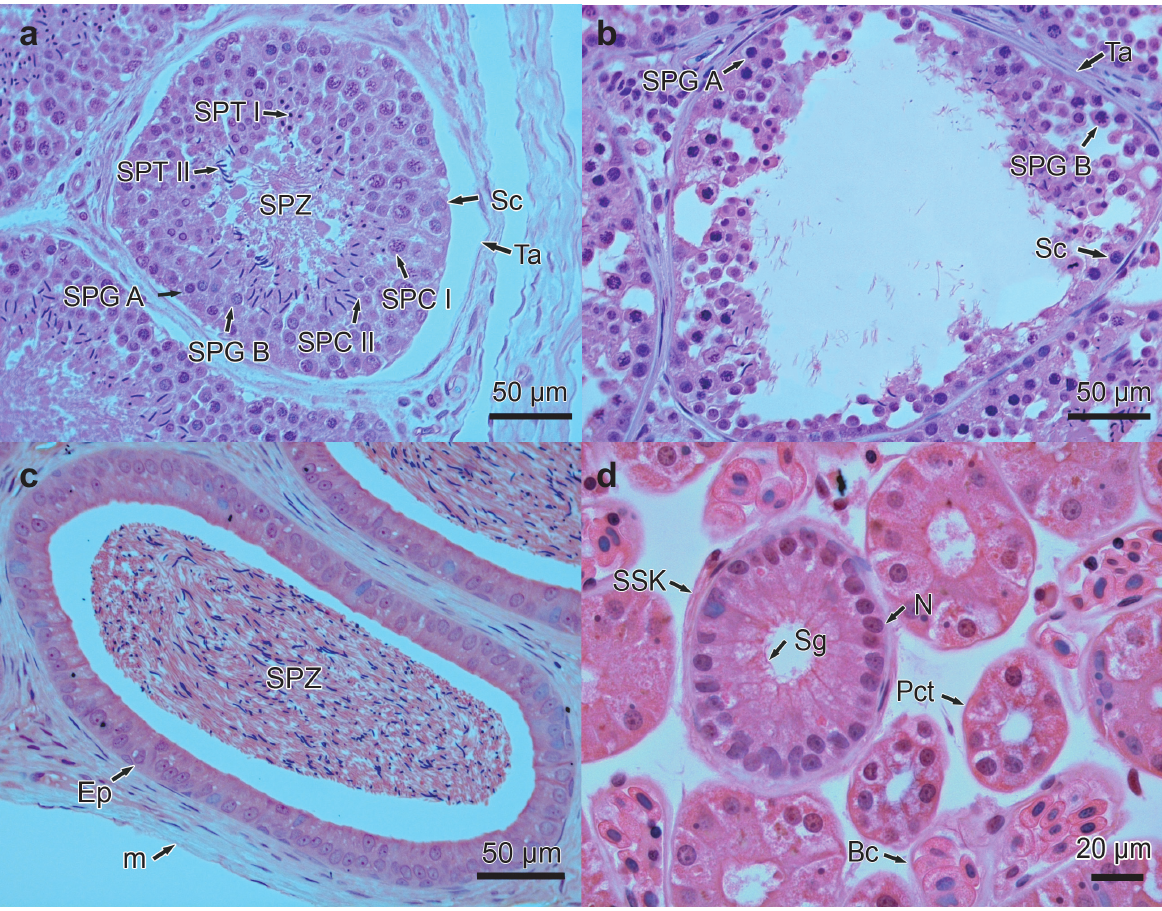
Figure 2. Transverse section of the testes (a, b), ductus deferens (c) and kidney (d) of Thamnodinastes strigatus from South Brazil. Transverse section of: testes in spermiogenesis (a) and regression (b) phases ductus deferens during spermiogenesis (c) and SSK in secretory peak (d). Ta, tunica albuginea SPG A, spermatogonia A SPG B, spermatogonia B SPC I, primary spermatocyte SPC II, secondary spermatocyte SPT I, spermatid I SPT II, spermatid II SPZ, spermatozoa Sc, Sertoli cell Ep, epithelium m, muscular layer Bc, blood capillaries N, nucleus Sg, secretory granules Pct, proximal convoluted tubule and SSK, sexual segment of the kidney. Light microscopy of samples stained with